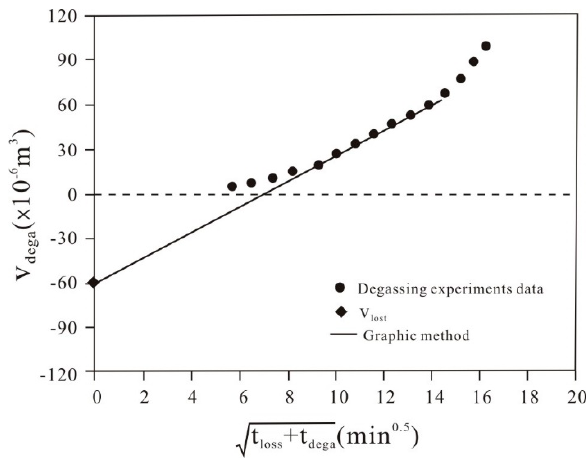
Figure 2. The determination of lost gas volume using a graphic method of the USBM.